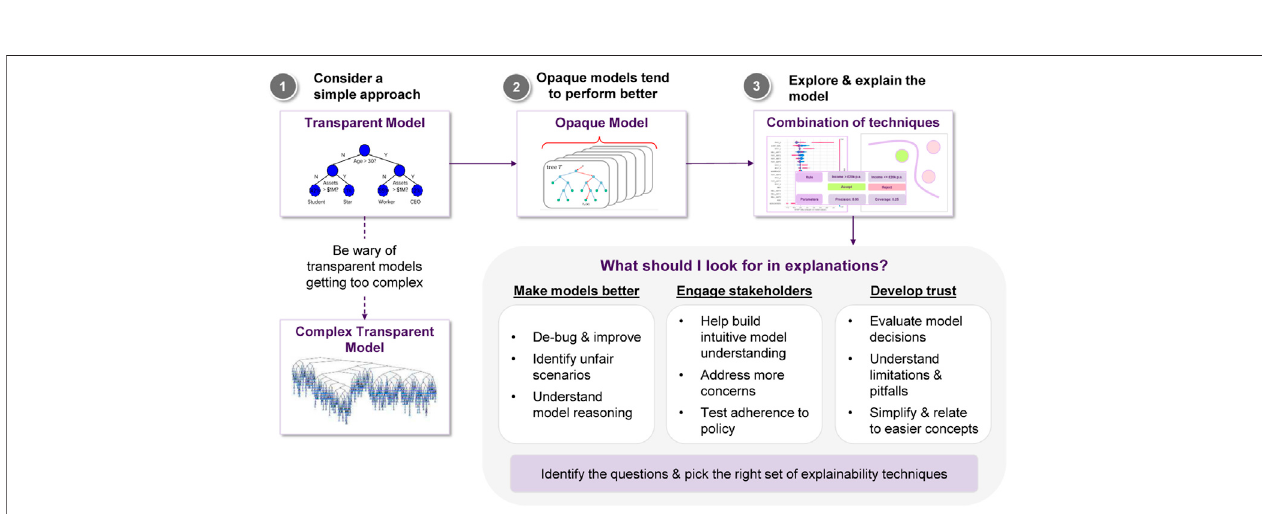
FIGURE 14 | A sample pipeline, that is, a “ cheat sheet ” of sorts for approaching explainability.